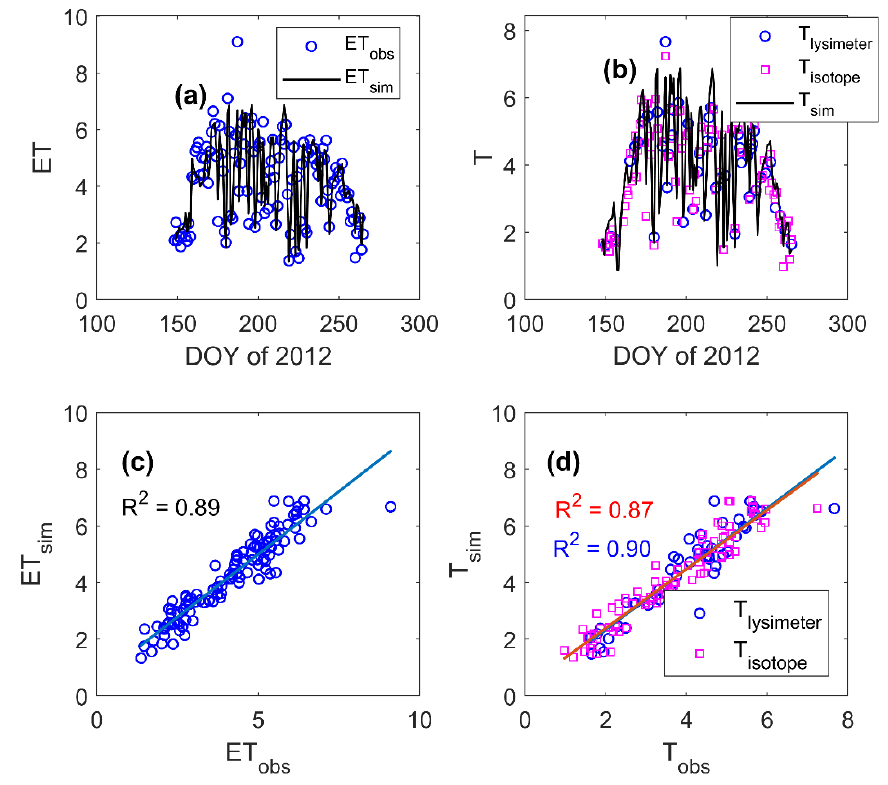
Figure 2. Comparisons of different evapotranspiration partitioning methods with the Penman-Monteith-Leuning model and measurements of lysimeter and isotope methods. The performance of the model was validated by using the flux tower measured Evapotranspiration (ET) ( a,c ), and the lysimeter and isotope observed transpiration (T) ( b,d ). ( a ) and ( b ) showed the time series results of the validation, while ( c ) and ( d ) showed the scatter plot of the validated results.